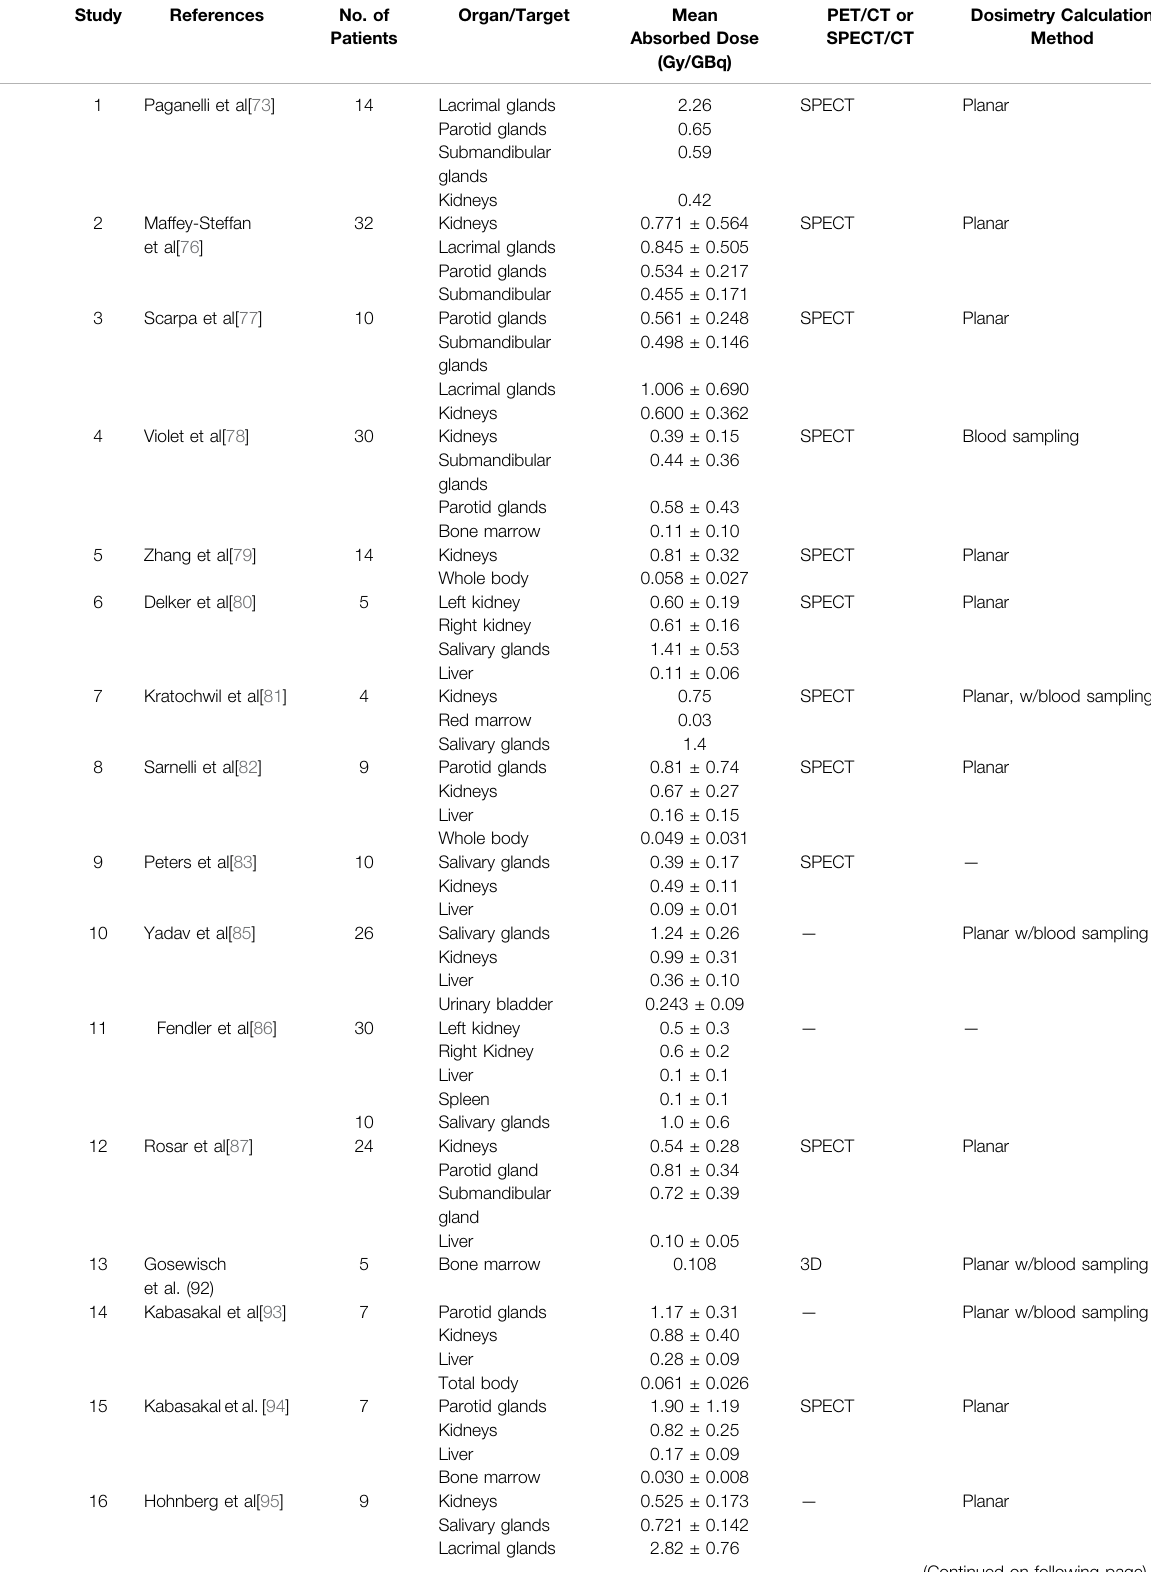
TABLE 3 | Normal organ absorbed doses after 177Lu-PSMA RNT. Radiophar-